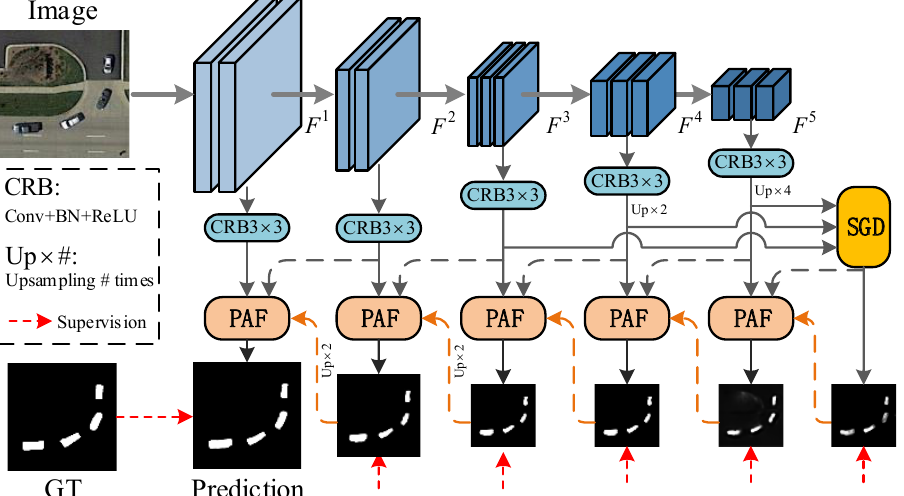
Figure 2. The pipeline of the proposed SARNet. Our model takes the RGB image (352 × 352 × 3) as input and uses the public backbone networks to extract multi-level features. These features are guided and integrated by SGD and PAF modules to gradually generate predictions supervised by